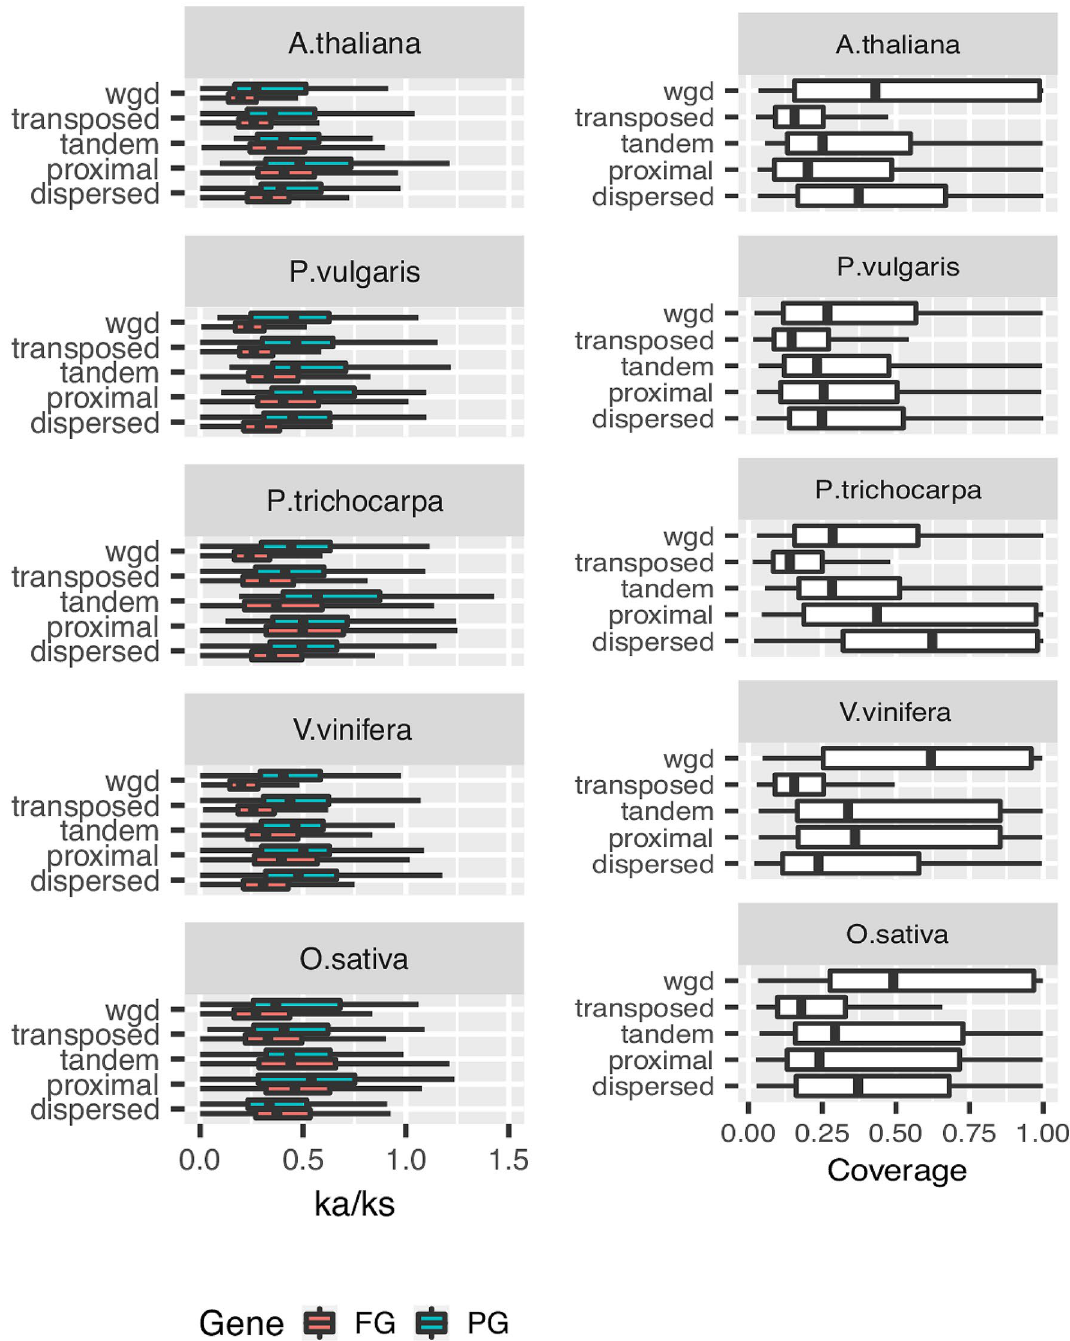
Figure 8. Evolutionary rates of the pseudogenes. ( a ) Comparisons of the omega ratios (ka/ks) calculated for the alignments of pairs of functional paralogs (blue) or pseudogene-parental locus pairs (red) in relation to the defined modes of duplication. ( b ) Coverage fractions of pseudogene protein alignments with the parental locus coding